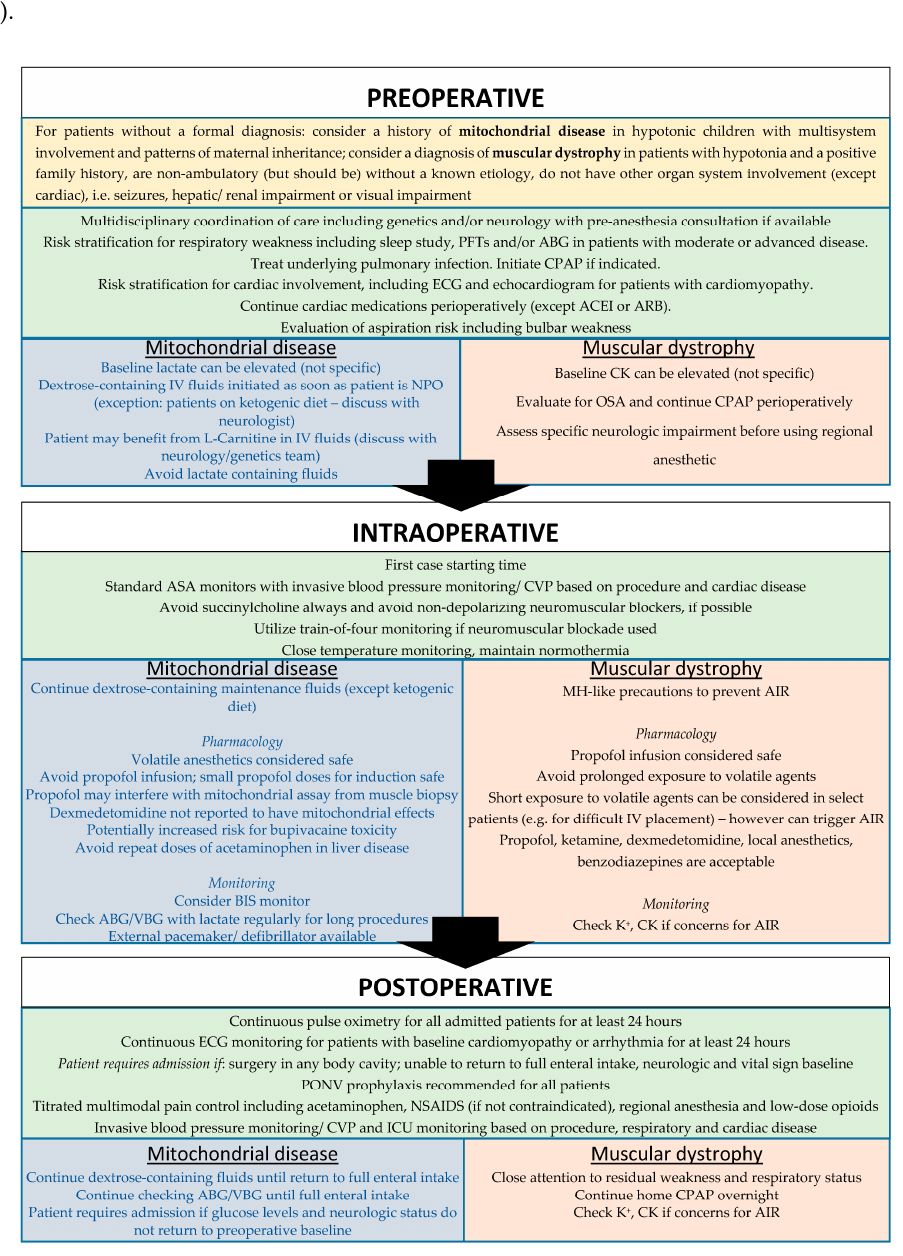
Figure 1. Perioperative framework for management of patients with neuromuscular disorders with specific considerations for mitochondrial disease and muscular dystrophies. PFT: pulmonary function test, ABG: arterial blood gas, CPAP: continuous positive airway pressure, ECG: electrocardiogram, ACEI: angiotensin-converting enzyme inhibitor, ARB: angiotensin II receptor blocker, NPO: nil per os ; OSA: obstructive sleep apnea; CVP: central venous pressure; AIR: anesthesia-induced rhabdomyolysis, BIS: Bispectral index, PONV: post-operative nausea and vomiting, ICU: intensive care unit, VBG: venous blood gas, NSAIDS: non-steroidal anti-inflammatory